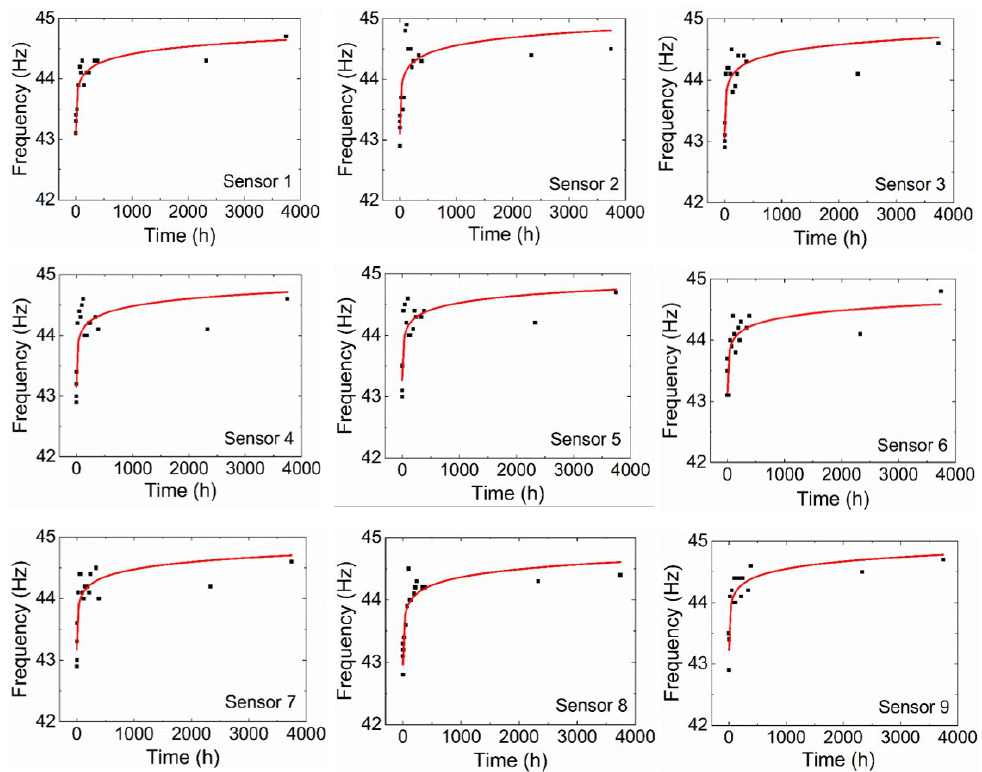
Figure 6. Natural frequency variation as a function of time of the corrosion process on the metal plate for the nine FBG-based sensors.